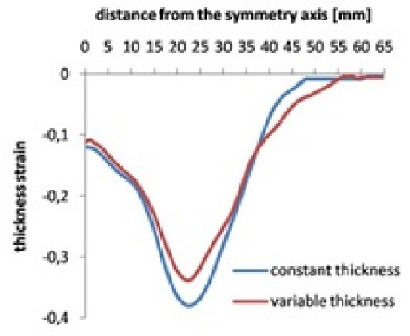
Figure 9. Comparison between experimental results in terms of thickness strain due to a stretching process on a sheet with an initial constant thickness and an initial variable thickness.